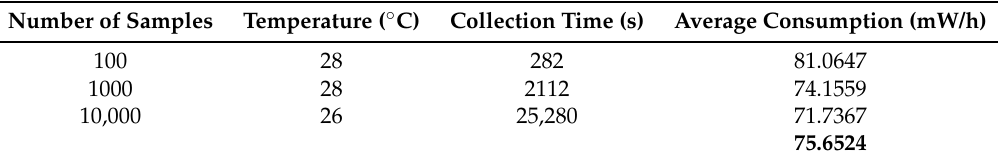
Table 9. Battery consumption of the implemented method per sample.